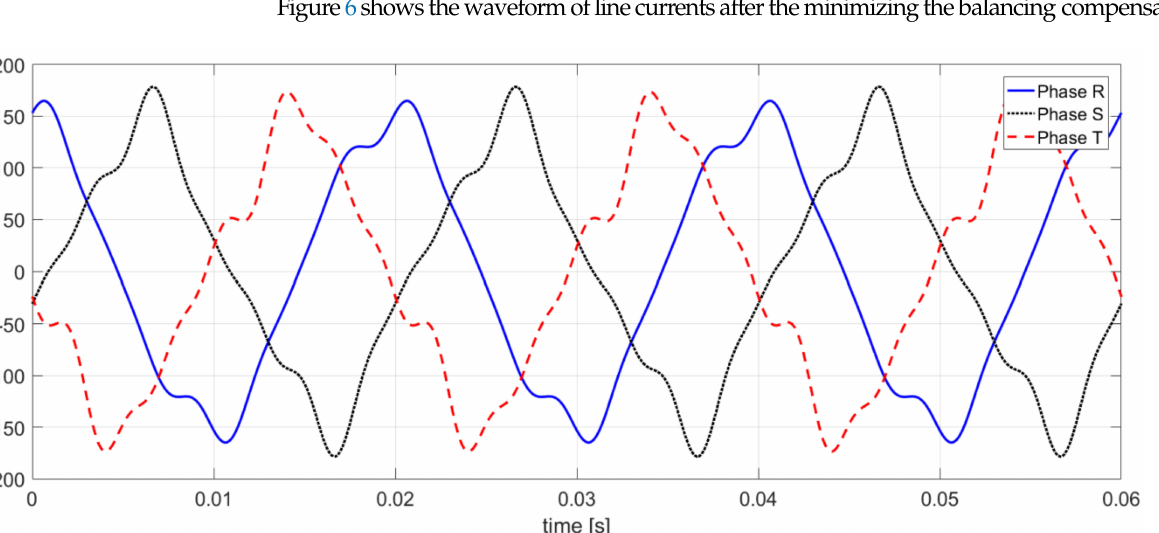
Figure6showsthewaveformoflinecurrentsaftertheminimizingthebalancing compensation.